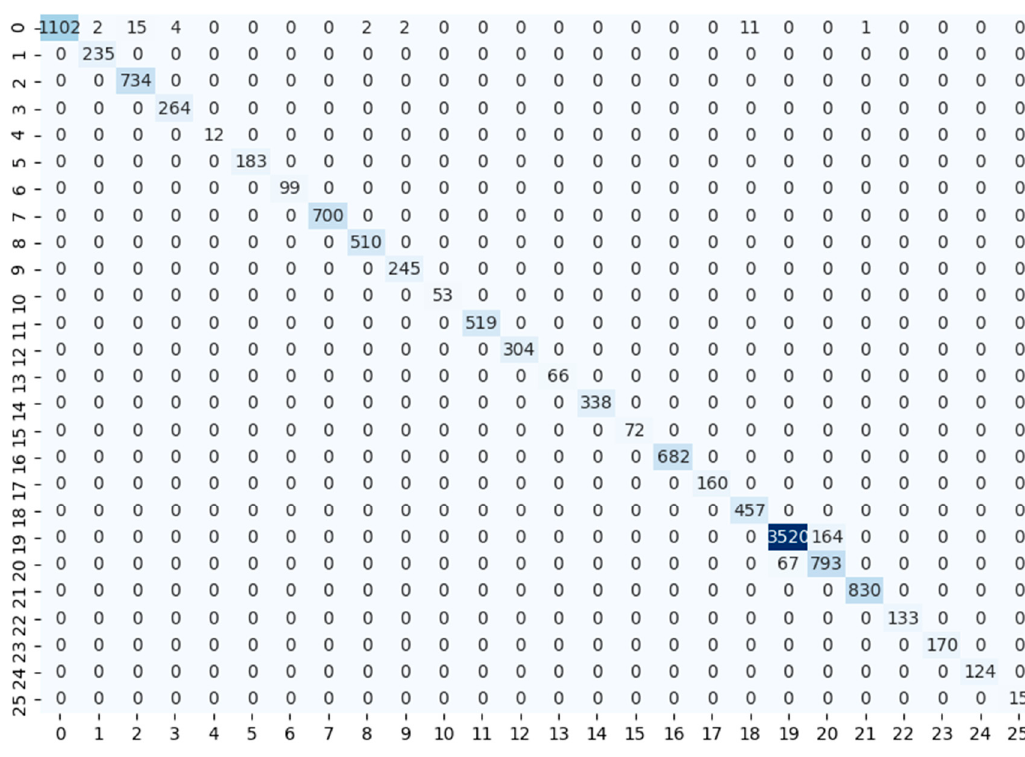
Figure 4. Confusion matrix for the training set.